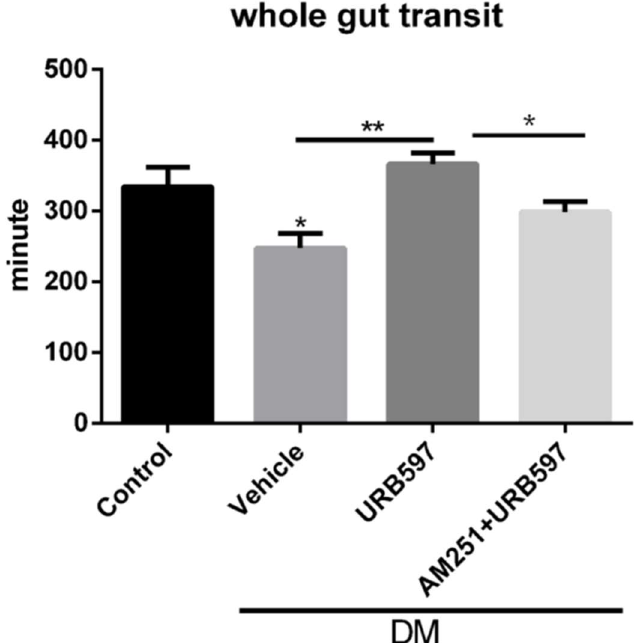
Figure 2. The effects of STZ-induced diabetes and FAAH inhibitor (URB597) on whole gut transit time measured by Evans Blue marker in the mouse. The diabetic mice had a faster transit (* p ≤ 0.05 vs. control); this effect was normalized with URB597 (5 mg/kg, IP) (** p ≤ 0.01 vs. vehicle treated diabetic mice). AM251 (0.5 mg/kg, IP) reversed the effects of URB597 on the transit time. ( n = 5 per group; one-way ANOVA F (3, 28) = 5.039; p ≤ 0.01).